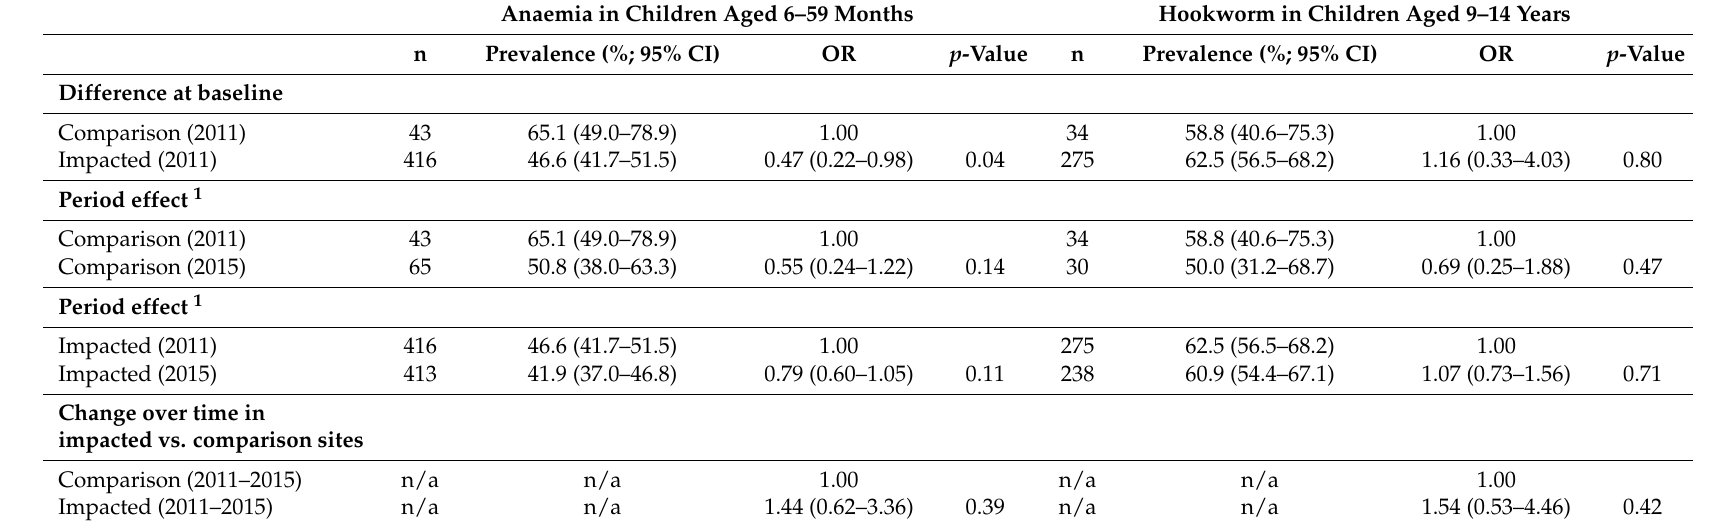
Table 4. Prevalences and period effects for anaemia and hookworm, Trident project, 2011 and 2015,